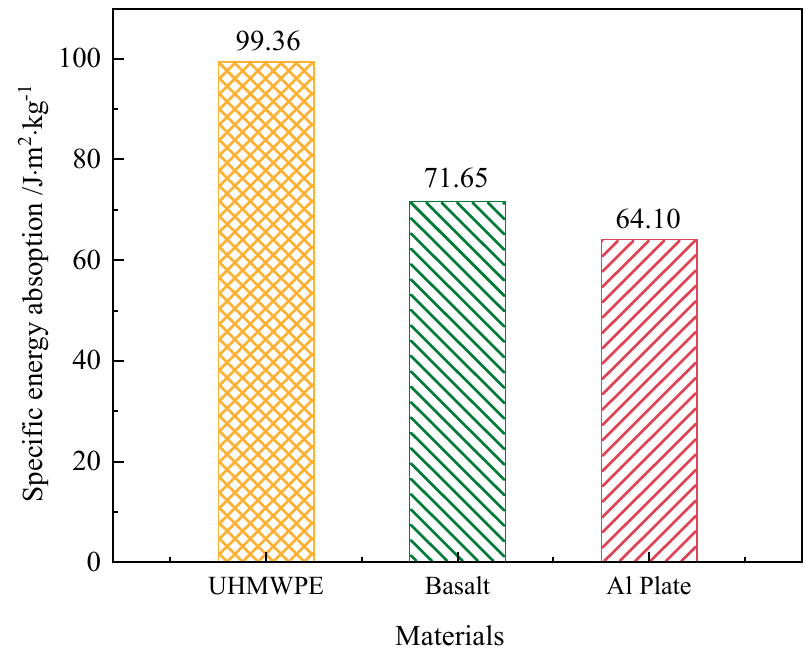
Figure 7. The comparison of specific energy absorption